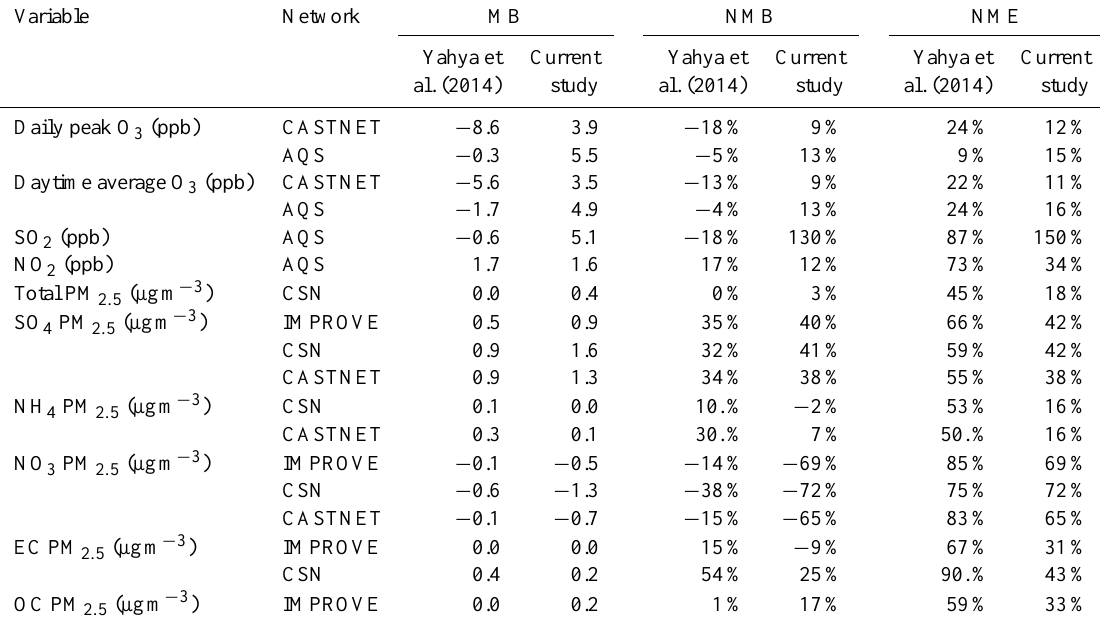
Table A2. WRF-Chem annual average predictive performance by pollutant in Yahya et al. (2014) and in the current study. Variable